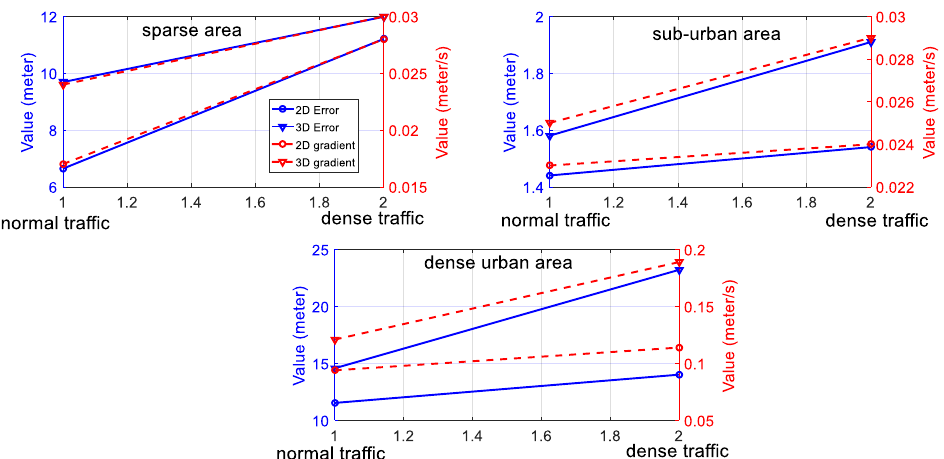
Figure 14. The relationship between the traffic conditions and the performance of NDT-based graph SLAM. The x-axis indicates the traffic condition (including normal traffic and dense traffic). The y-axis on the left side represents the value of positioning error and the y-axis on the right side indicates the positioning error gradient.